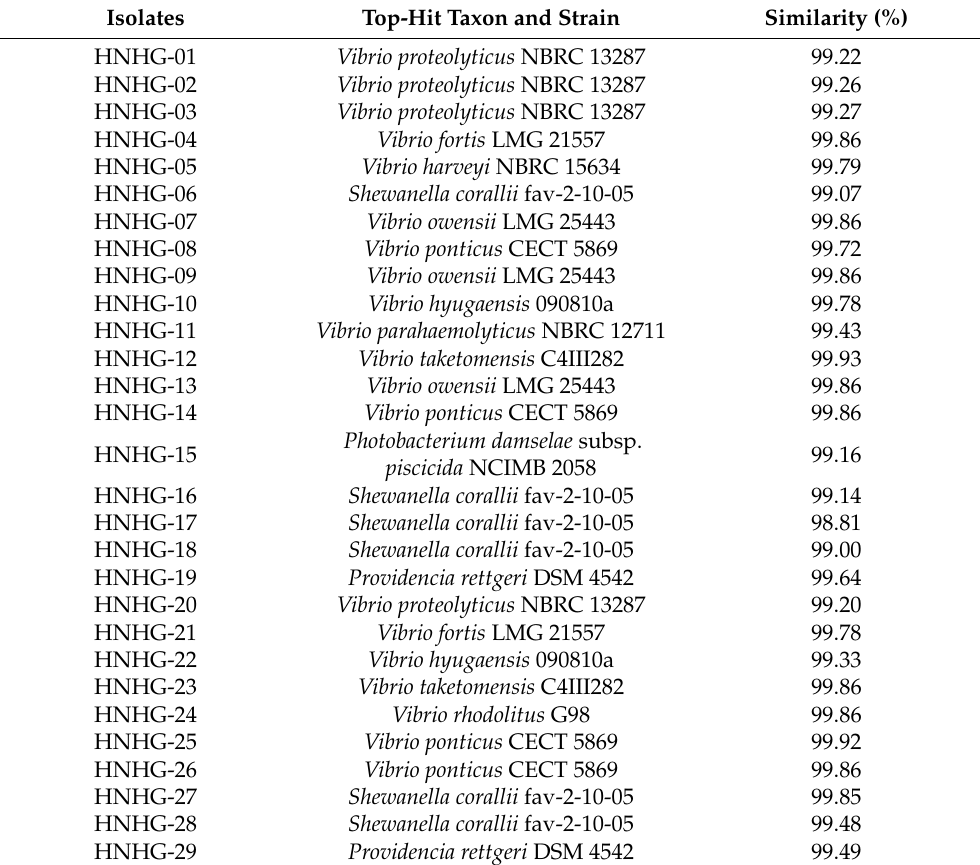
Table 1. 16S rRNA gene sequencing and alignment results of strains isolated from the livers of diseased hybrid groupers.